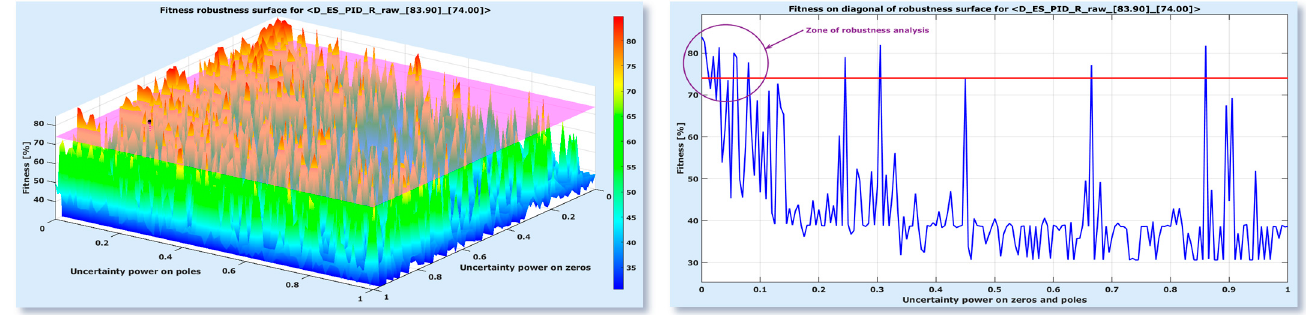
Figure 26. Principle of robustness margin estimation for increasing uncertainty power.